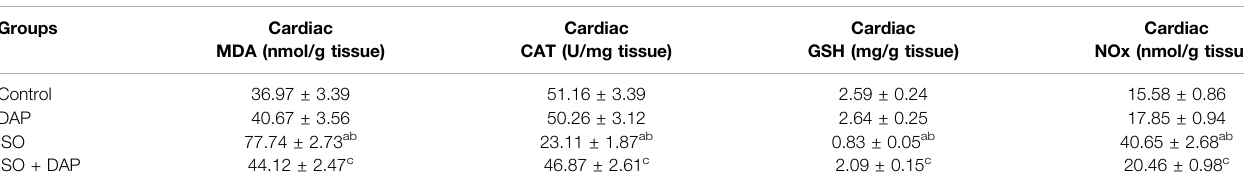
TABLE 1 | In fl uence of DAP on oxidative stress markers in MI in rats.